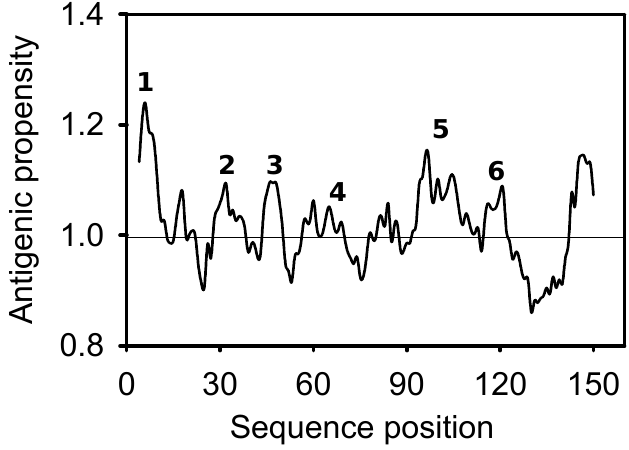
Figure 10. Predicted antigenic properties of cSOD1 using Kolaskar and Tongaonkar method [43]. Six potential antigenic peptides having more than 1.0 antigenic propensity and seven or more amino acids in lengths are predicted.